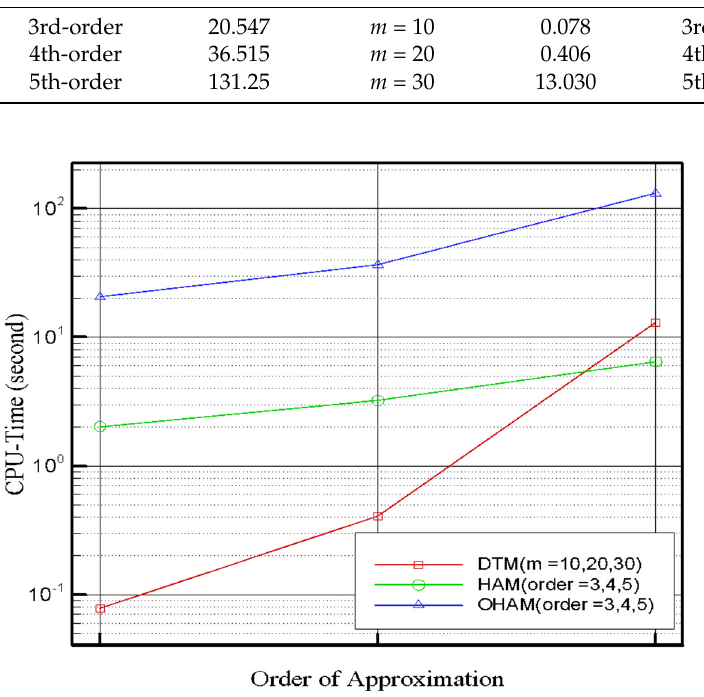
Figure 4. Comparison of CPU time of different approaches at different orders of approximation.